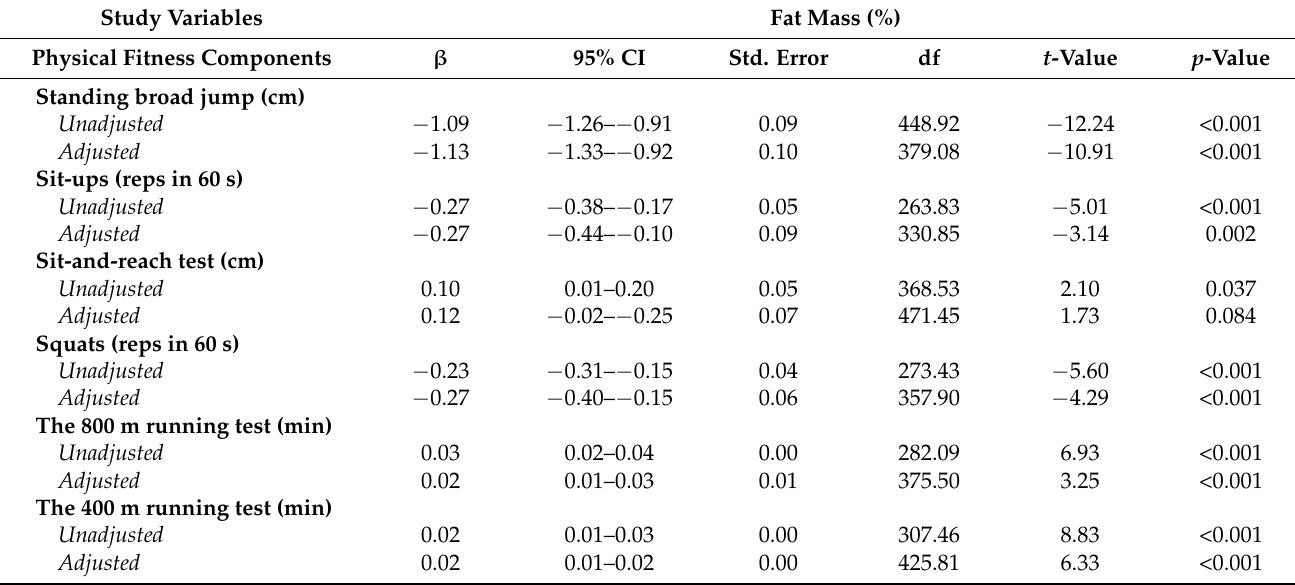
Table 2. The mixed model estimates of the association between fat mass with other physical fitness components (N =